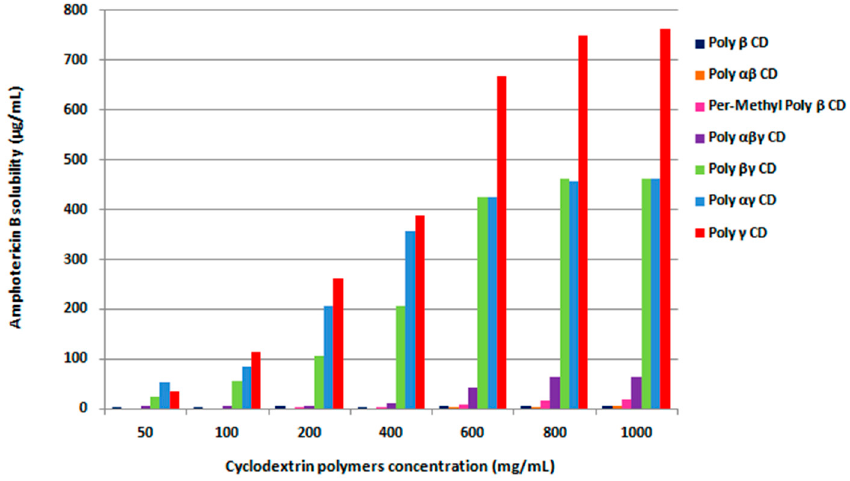
Figure 1. Solubility diagrams of AmB in presence of cyclodextrin polymers at 37 °C ( n = 3).